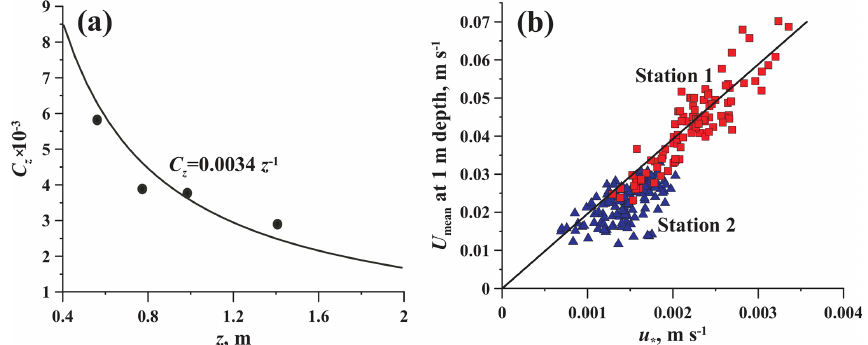
Figure 10. Bulk characteristics of the ice boundary layer: (a) bulk transfer coefficient for momentum C Z as a function of distance from the IWI, where dots are values calculated using the horizontal velocity data from point measurements by 2-D INFINITY-EM loggers, and the line is an analytical approximation; (b) relationship between the mean flow velocity at z = 1m and the turbulent stress.